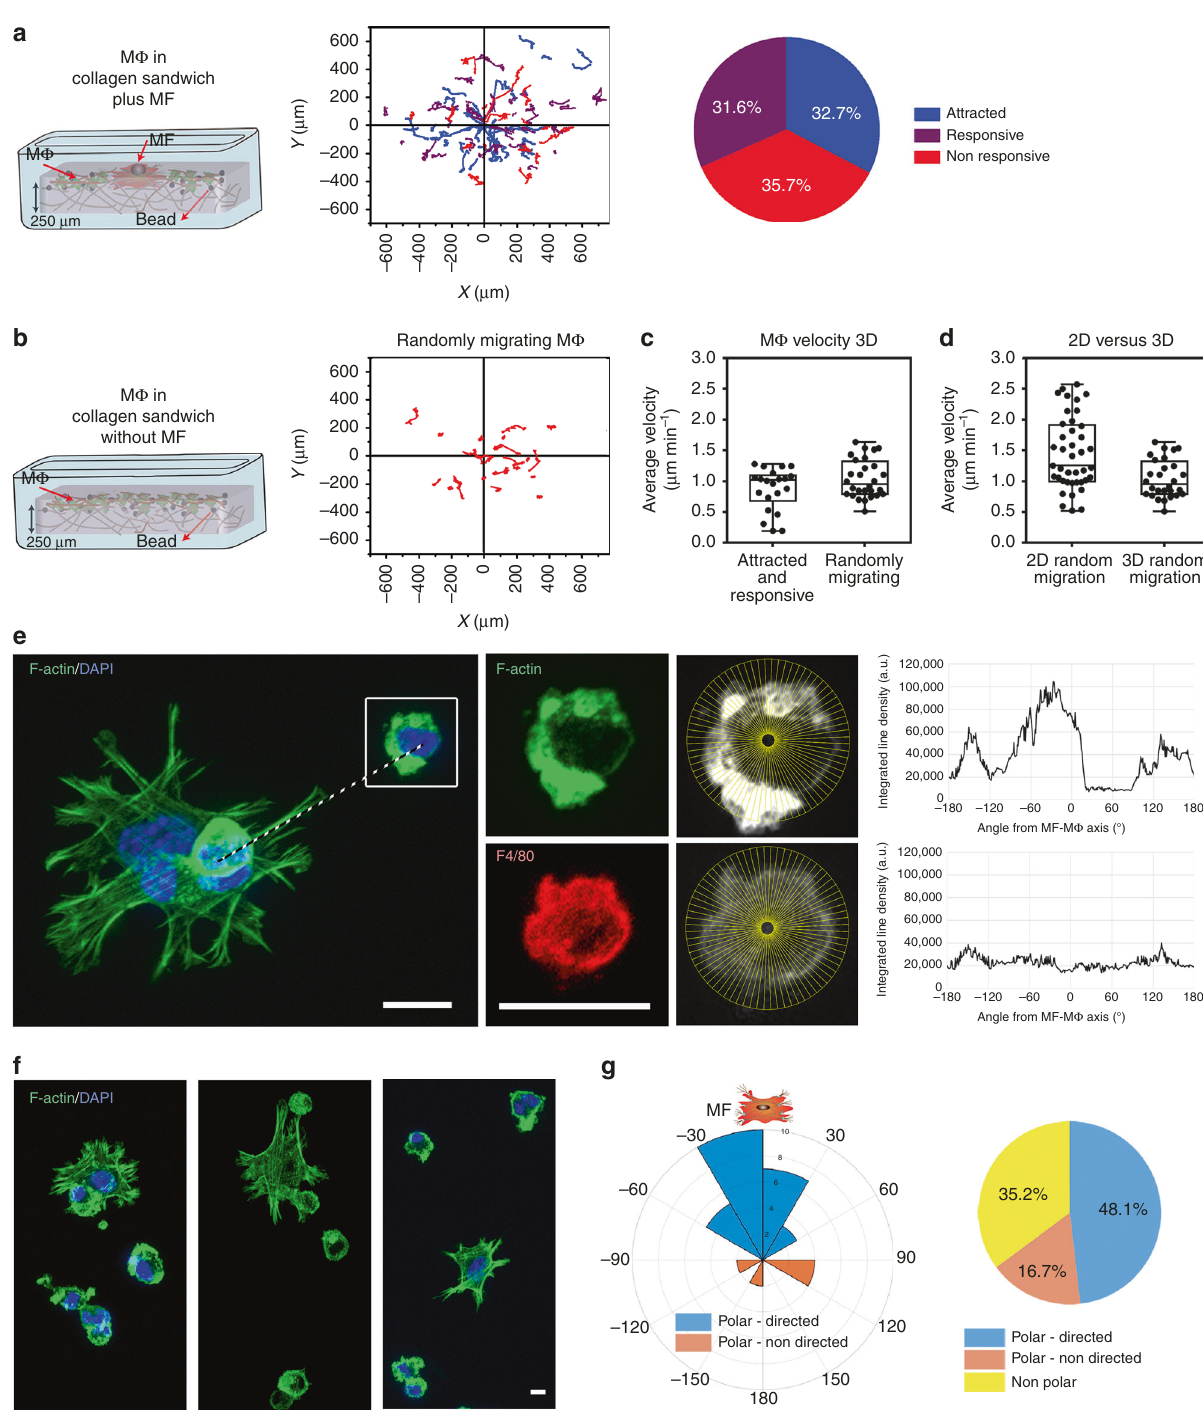
Fig. 3 Macrophages (M ϕ ) are attracted and orient toward myo fi broblasts (MFs) within fi brillar collagen extracellular matrix (ECM). M ϕ within three- dimensional (3D) collagen gel sandwich cultures were tracked over 12 h either a with or b without MFs being present. M ϕ tracks (blue-attracted M ϕ , purple-responsive M ϕ , red-non-responsive M ϕ ) were plotted with respect to the MF position or the image center (0,0) ( a , 40 M ϕ , 8 experiments; b , 28 M ϕ , 8 experiments). Average local migration velocities were compared between c M ϕ that were attracted and responsive ( n = 22) or M ϕ that were non-responsive ( n = 28) and d between M ϕ randomly migrating in 2D ( n = 41) or 3D collagen ( n = 28). Shown are medians (center lines) of box (25th to 75th percentiles) and whisker (minimum to maximum) plots. e M ϕ and MFs were co-cultured within 3D collagen gel sandwich cultures for 3 h, followed by staining for F-actin (Phalloidin, green), M ϕ marker (F4/80, red) and nuclei (DAPI, blue). Integrated F-actin fl uorescence intensity pro fi les along lines drawn from the M ϕ centroid in 1° angle distances (shown for every 5°) over 360° were used to identify the leading (highest actin content). Zero angle was de fi ned by a line connecting M ϕ and MF centroids. f Three additional examples for M ϕ orientations toward MFs in the same ECM. g Peak angles from e were summarized to relate angle orientation of M ϕ to the position of MFs (0°) in rose plots. M ϕ with orientation angles <60° were considered to have polar-directed orientation toward MFs ( n = 57). All scale bars: 25 µ